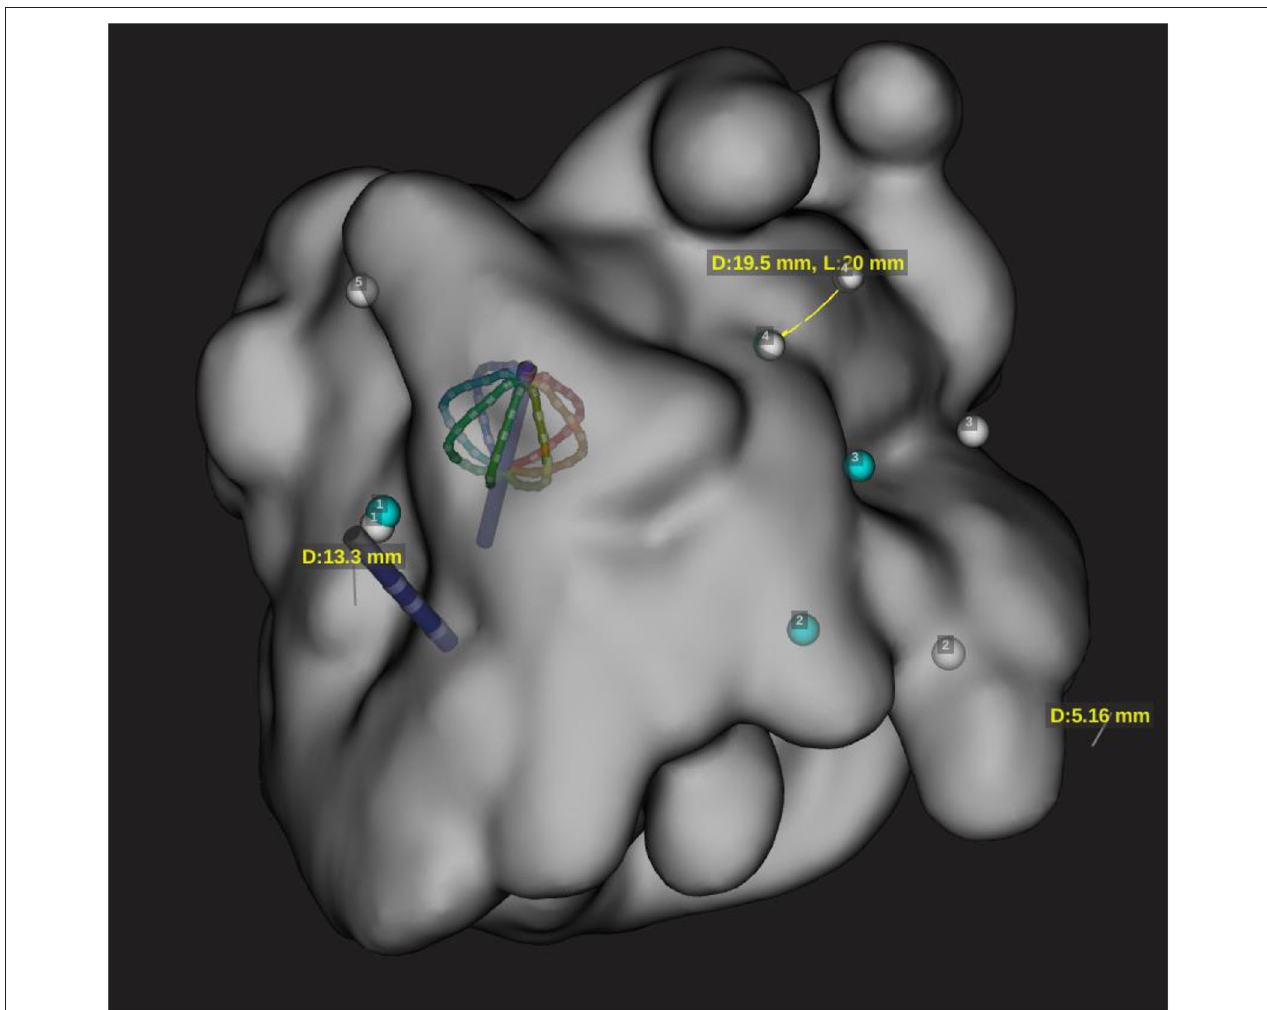
FIGURE 3 | Representation of both Orion and DT catheter in the 3D map on the EAM. This snapshot is showing catheter shift during RF application with configuration 3.1 and distance measurement of 19mm for configuration 3.3.